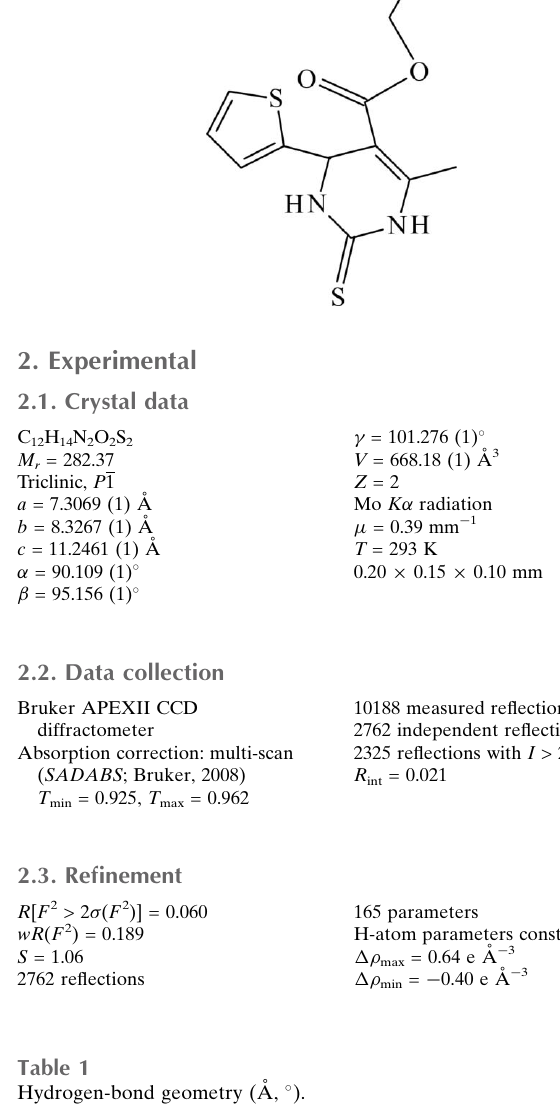
Hydrogen-bond geometry (A˚ , (cid:2)